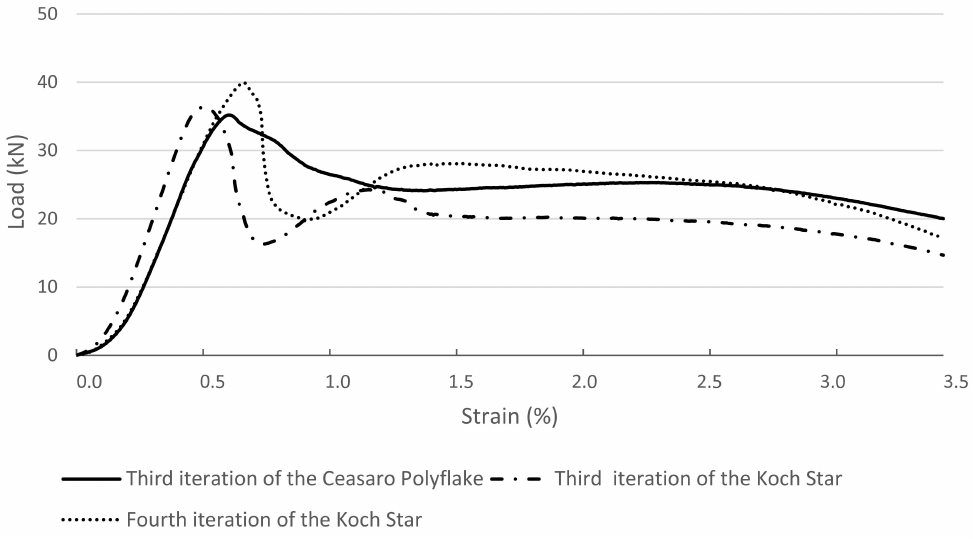
Figure 5. Load–strain relations for the tested columns with the cross-section in the shape of the third iteration of the Ceasaro Polyflake, third and fourth iteration of the Koch Star. Table 4. Geometrical characteristics of plastic